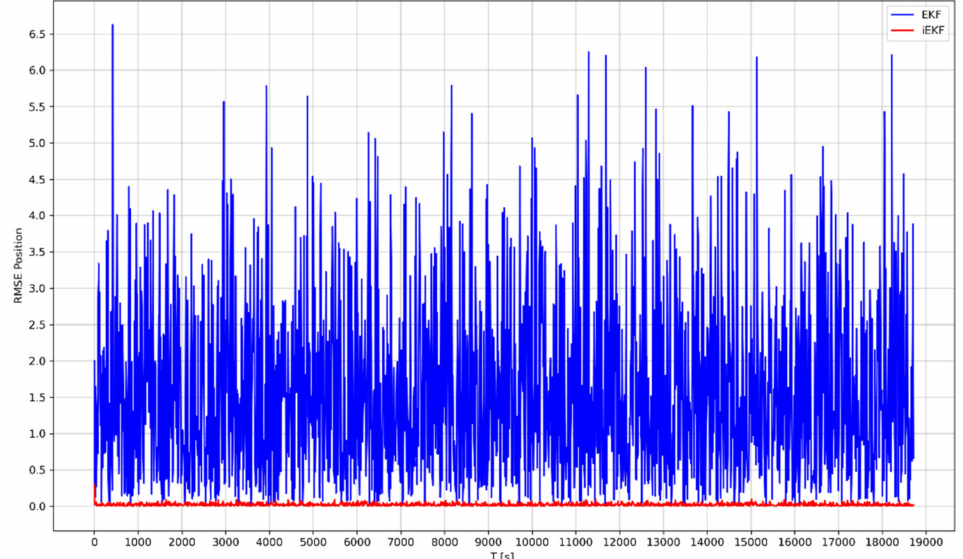
Figure 14. Case 2: comparison of the EKF RMSE and iEKF RMSE for the position.